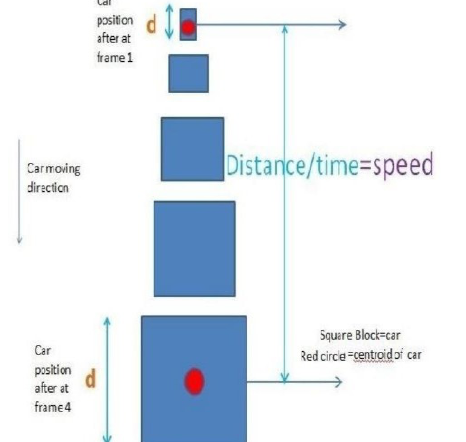
Fig. 15 : Estimating Speeds through Different